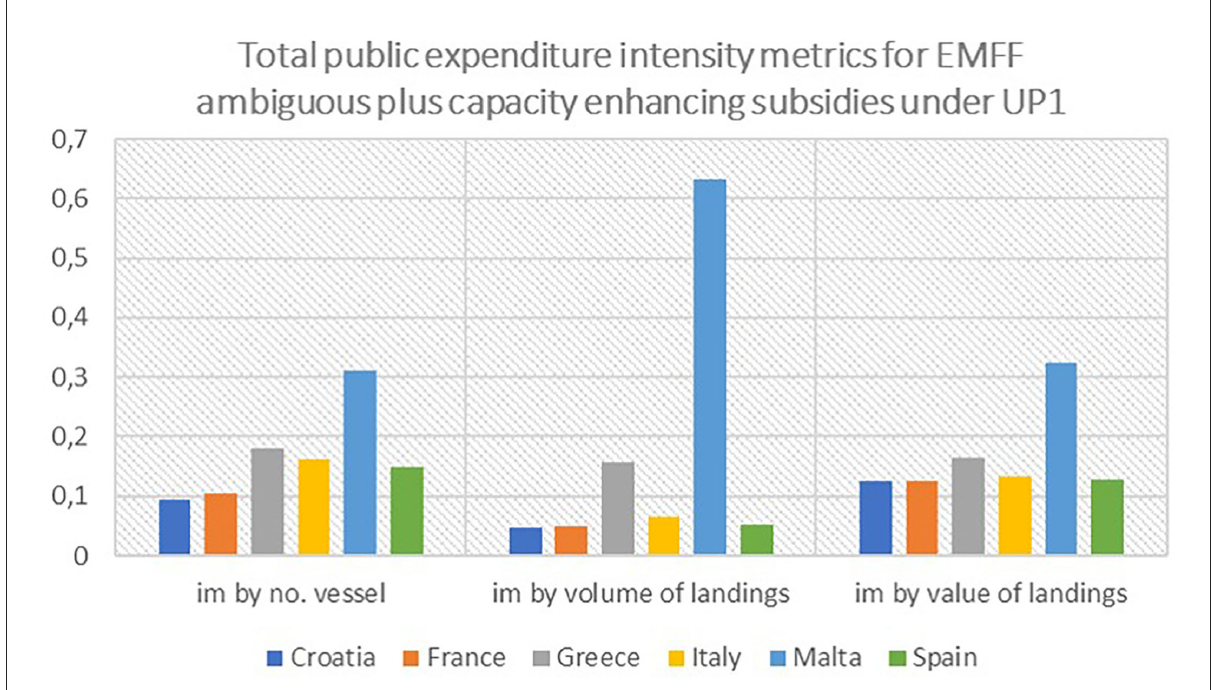
FIGURE14 Total public expenditure intensity metrics for ambiguous and capacity-enhancing subsidies by MSs. Source: elaboration on data from EMFF lists of